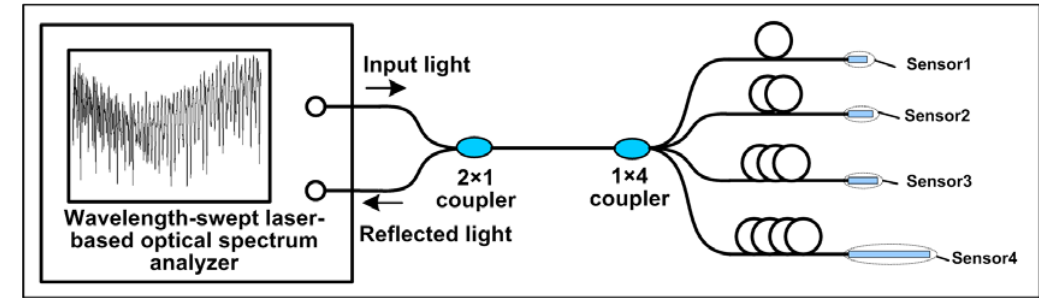
Figure 5. Schematic diagram of the multiplexing system.